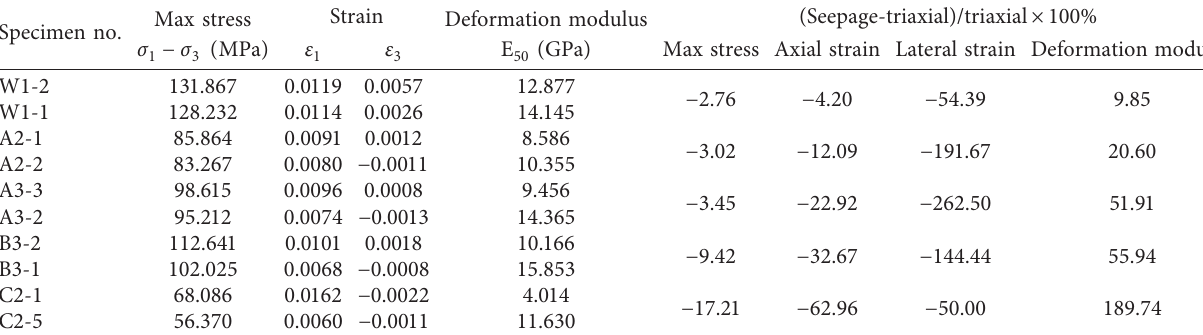
Table 4: The characteristics of the strength and deformation of the test results. Specimen no.